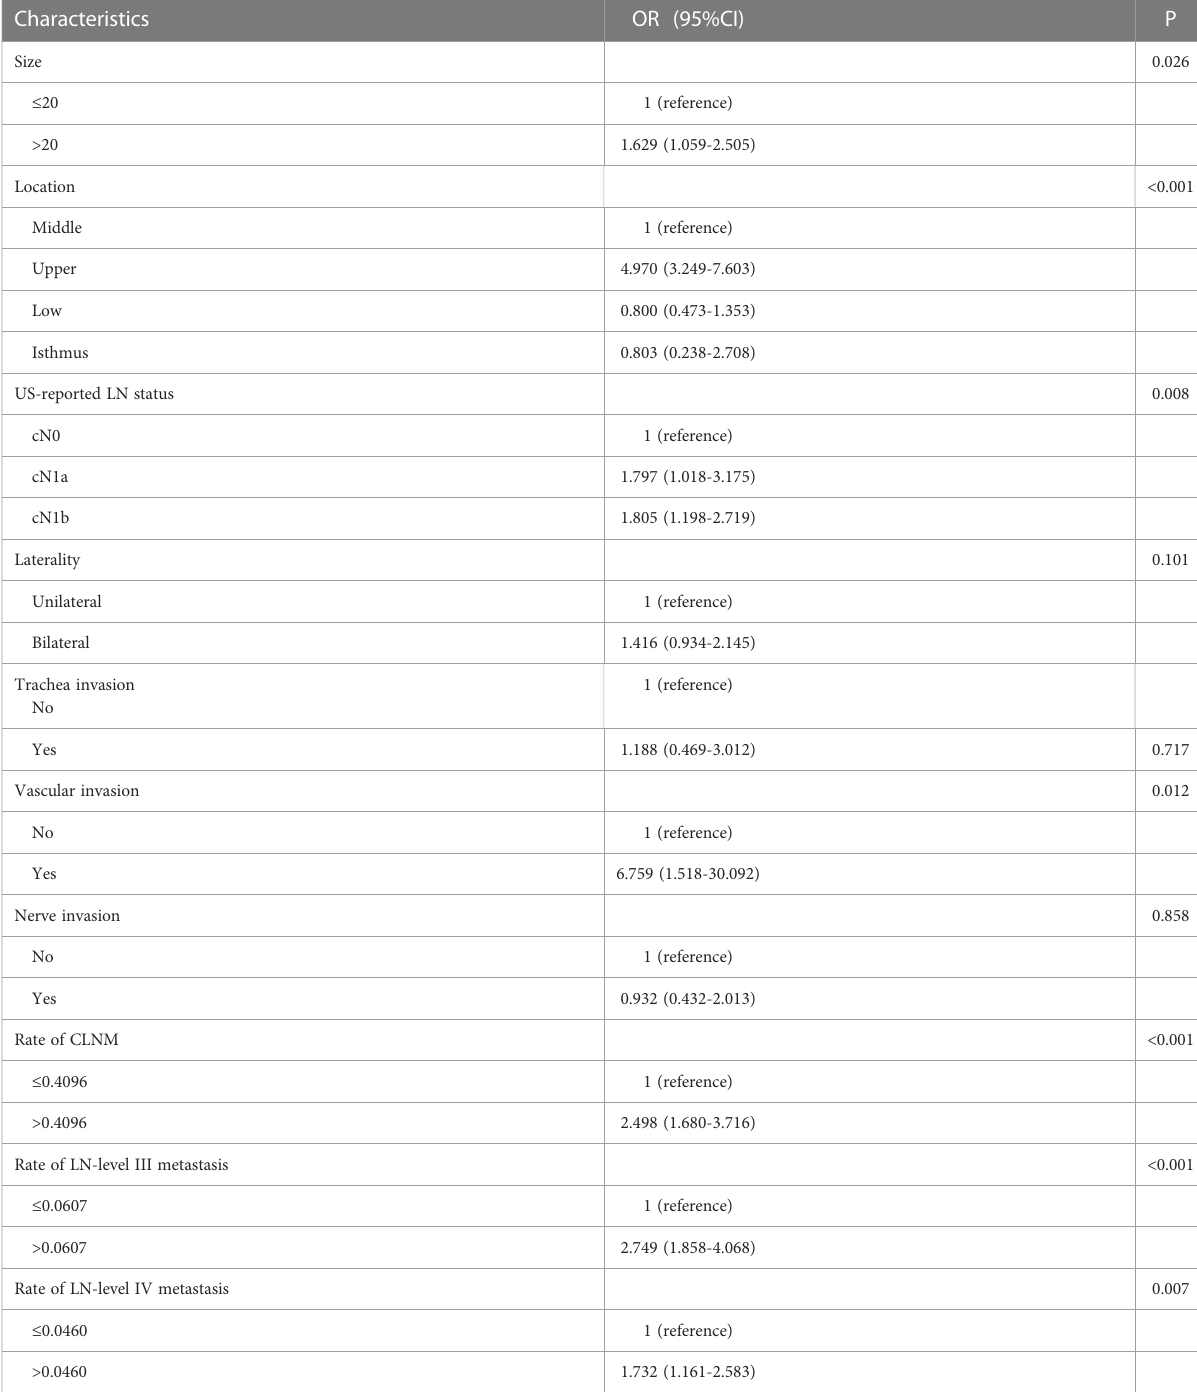
TABLE 3 Multivariate logistic regression analysis of factors between the negative and positive of LN-level II.